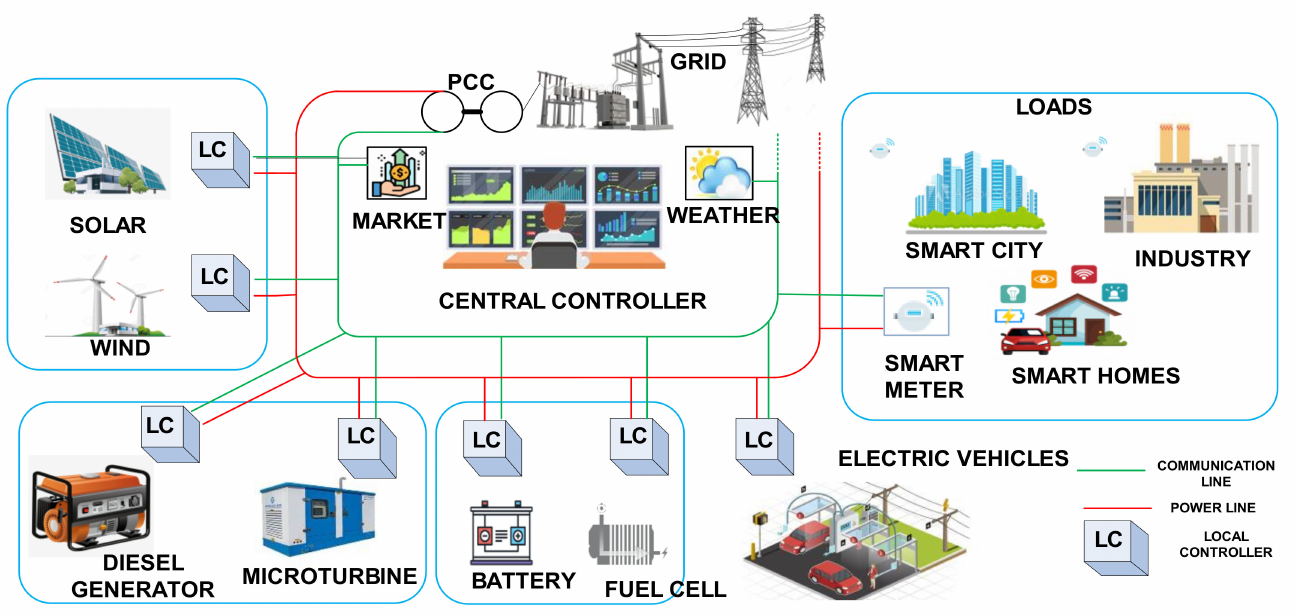
Figure 1. Structure of a typical